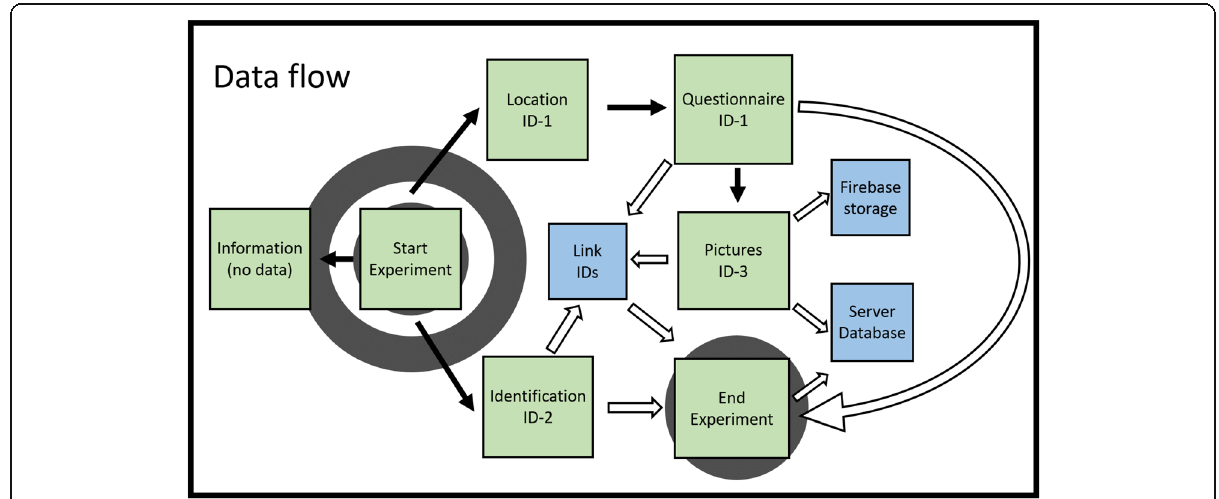
Fig. 3 Data flow of the application. Application activities are represented in green boxes, data holders are in blue boxes. Solid block arrows represents application ’ s workflow while white arrows carry data. Data generated by users carry unique IDs and are linked before being sent to the server. Activities performed alone are not linked. Picture data are sent in two places: a Firebase storage where they can be viewed directly and the server where they are stored as a byte